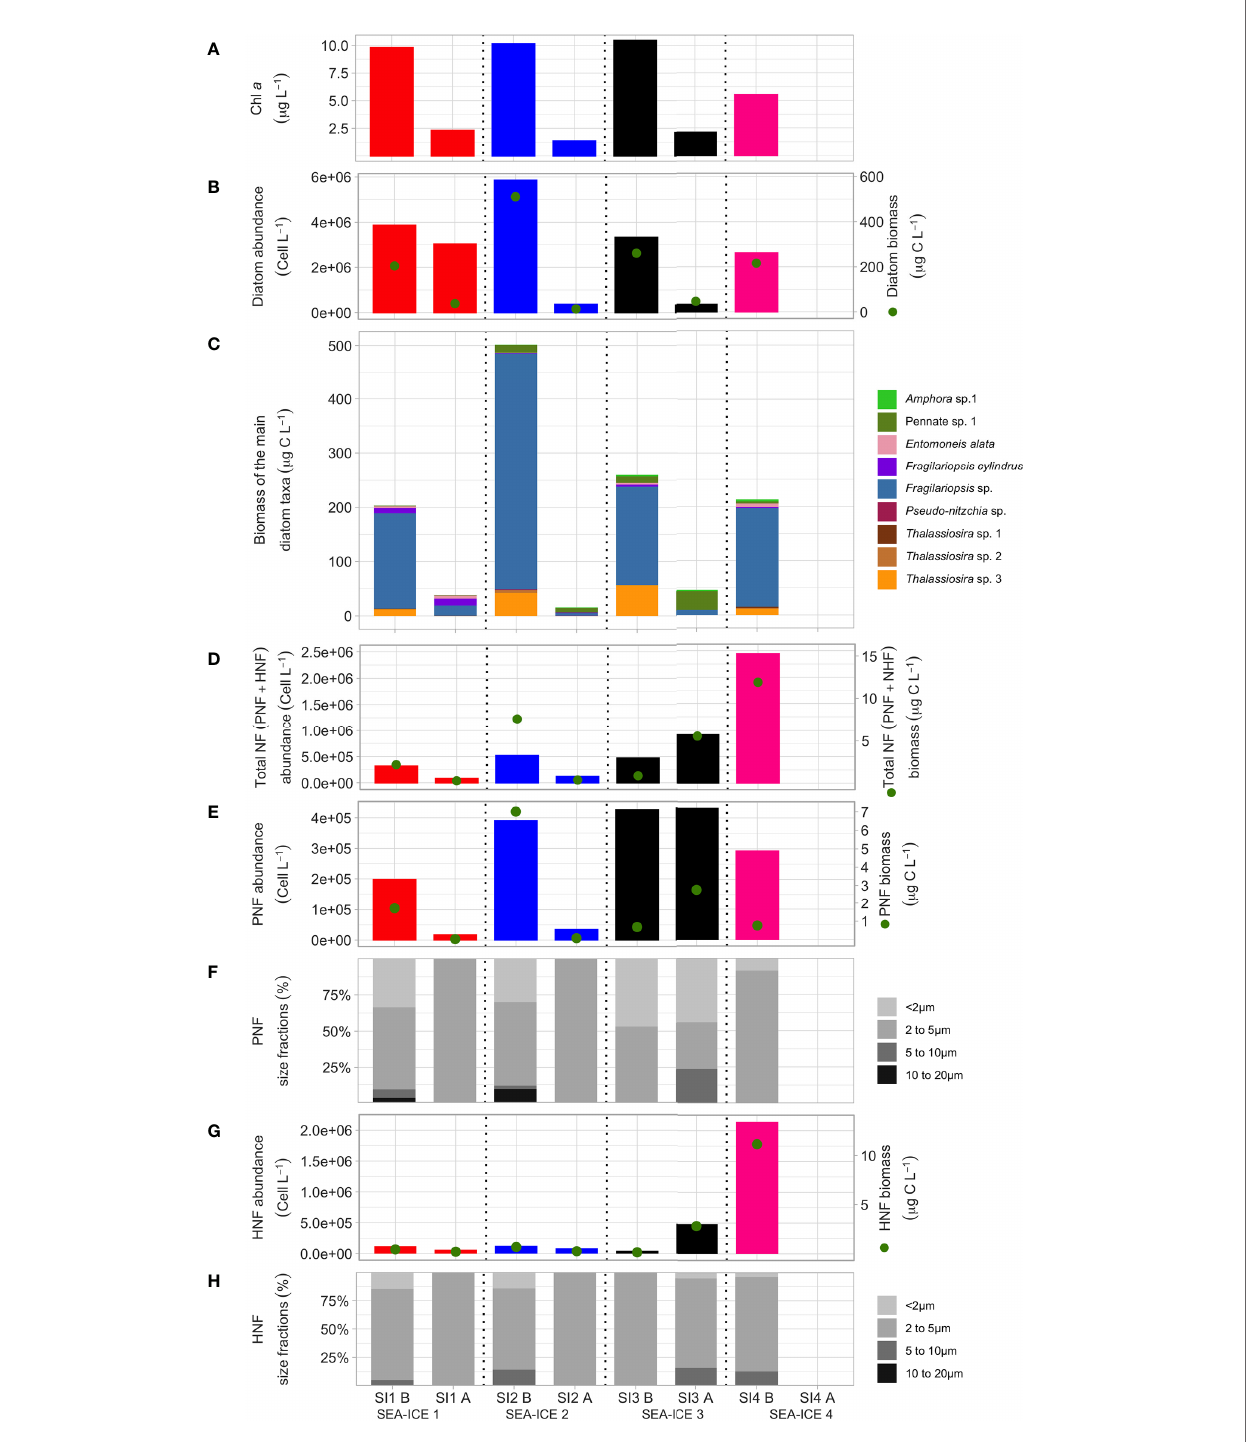
FIGURE 1 | Changes in micro- and nanoplankton related variables measured in the four sea ice experiments before and after the aerosol generation period. For each experiment the fi rst bar corresponds to the values estimated before ( “ B ” ) bubbling; the second bar shows the values after ( “ A ” ) bubbling. From top to bottom, the graphs show (A) Chl a concentration; (B) diatom cell abundance (bars) and the corresponding carbon contribution (biomass, green dots); (C) biomass of the main diatom taxa; (D) abundances (bars) and biomass (green dots) of nano fl agellates (NF) including the sum of PNF and HNF; (E) PNF abundance and biomass, as in (d); (F) size class distributions of PNF; (G) HNF abundance and biomass as in (d); (H) size class distributions of HNF. Please note that diatom (B) depositing are large (very often > 20µm) relative to nano- fl agellates (PNF, HNF very often <